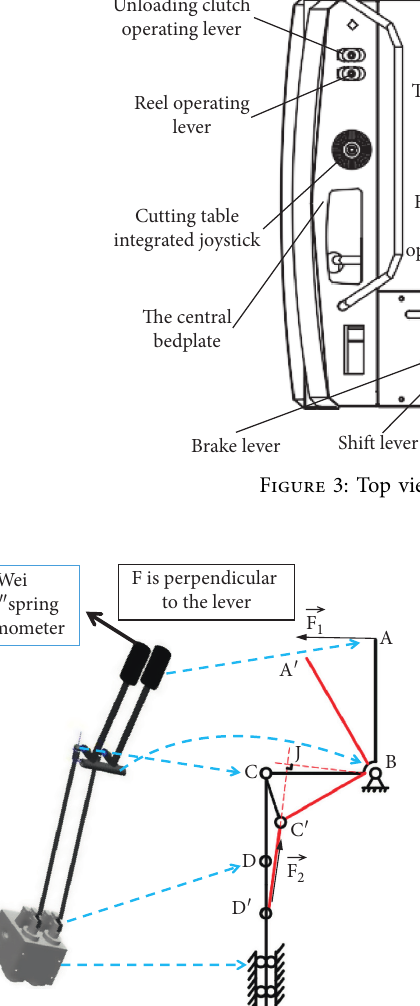
Figure 4: Small switch travel of the reel and principles of the operating